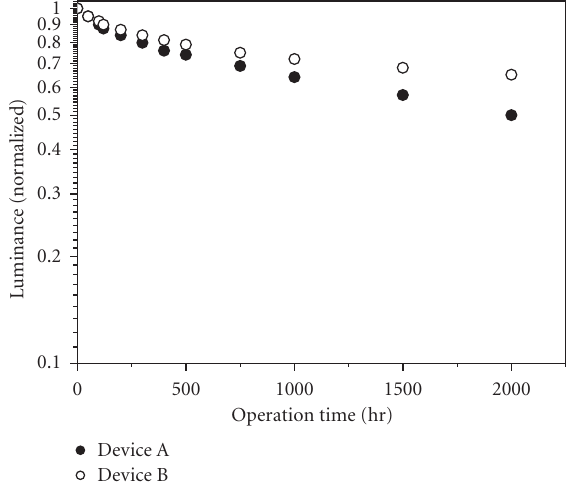
Figure 5: The luminous power e ffi ciencies of Devices A and B, which are plotted against current density.